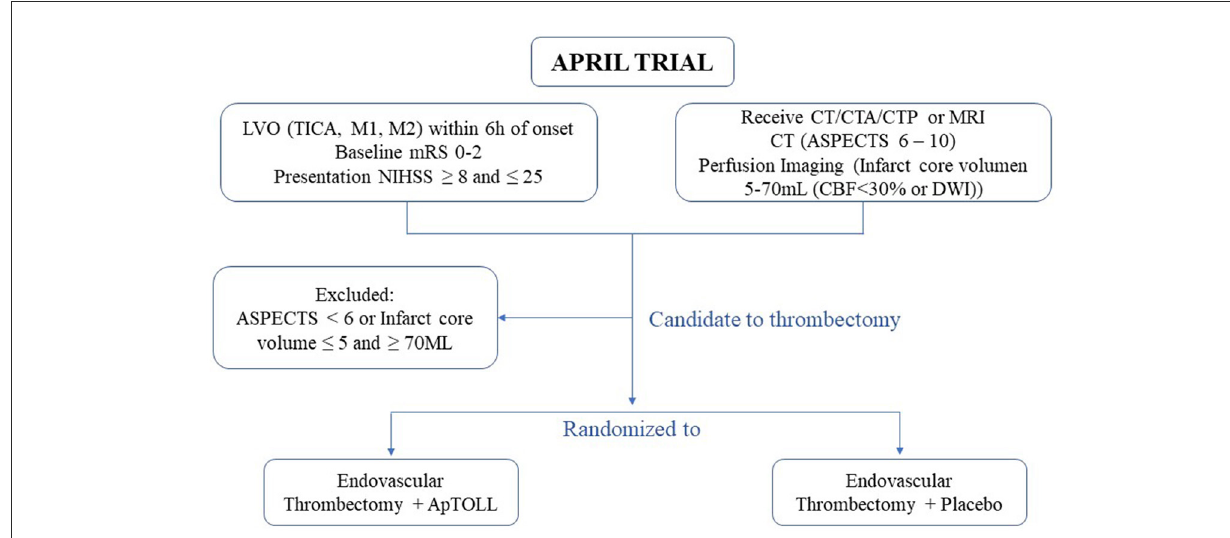
FIGURE2 Procedures in APRIL trial. The flow of determinations to confirm stroke-related eligibility criteria in those patients enrolled in the APRIL trial.